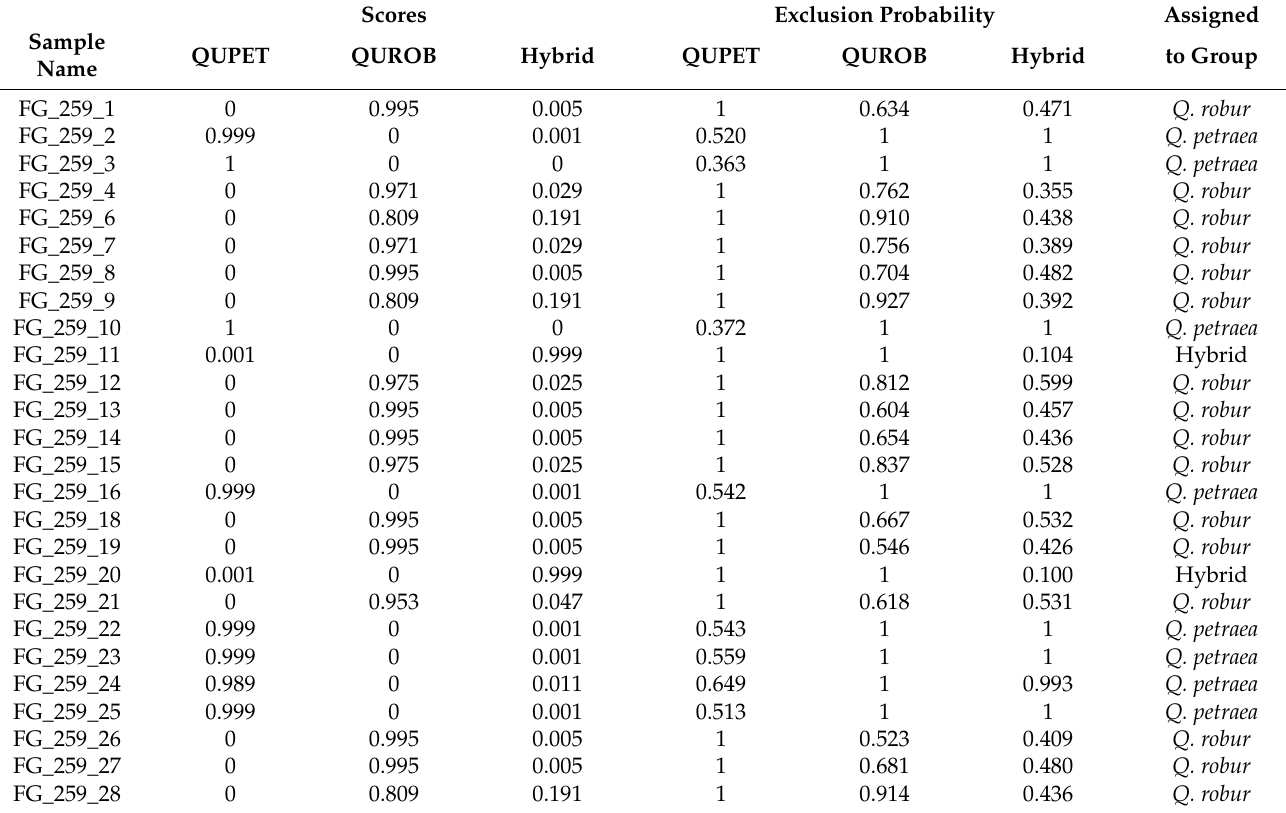
Table 6. Result of assignment test of individuals with unknown species